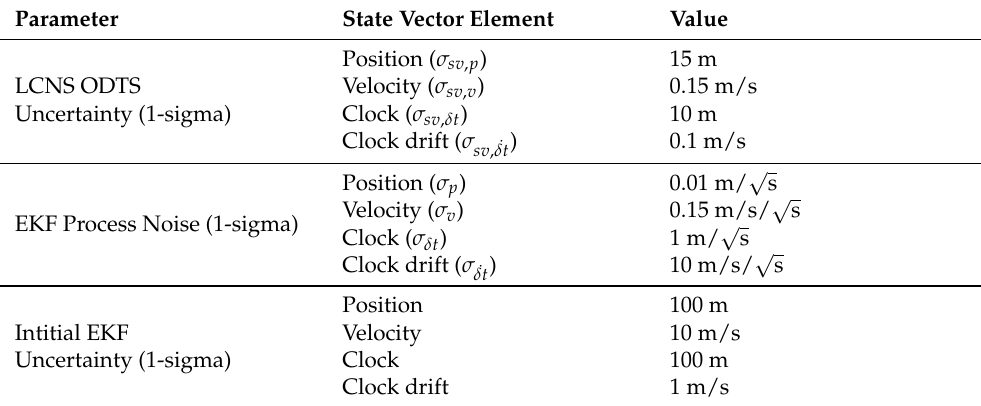
Table 6. Configuration settings used for the EKF covariance analysis; all values are